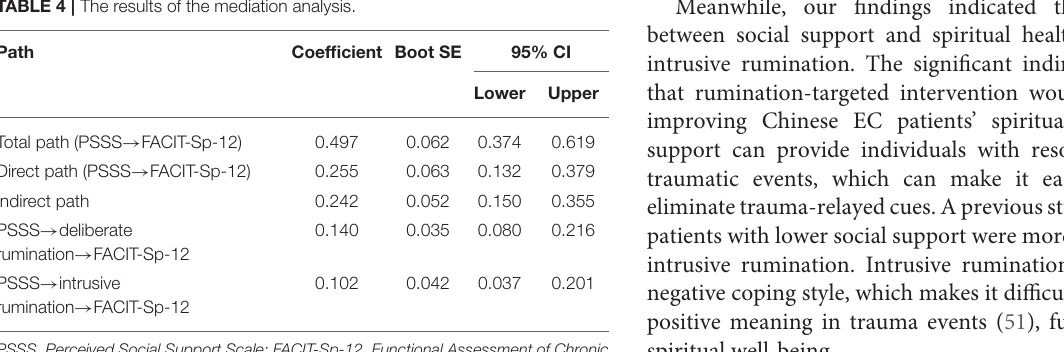
TABLE 4 | The results of the mediation